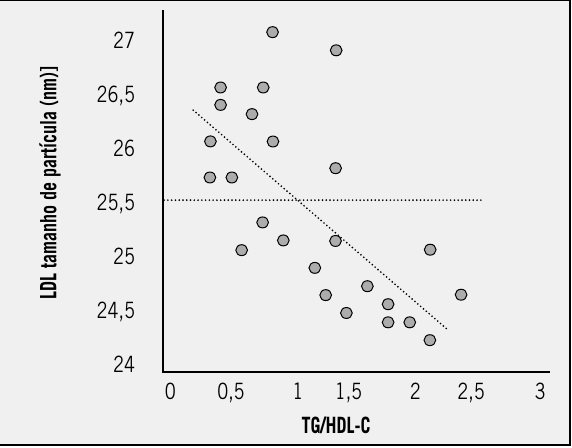
Figura 2 – Índice obtido da razão TG/HDL-C (1,9). O valor da razão obtida quando aplicado à figura e o conceito de Maruyama et al. (12) estimam, nesse caso, o tamanho de partículas de LDL inferiores a 25